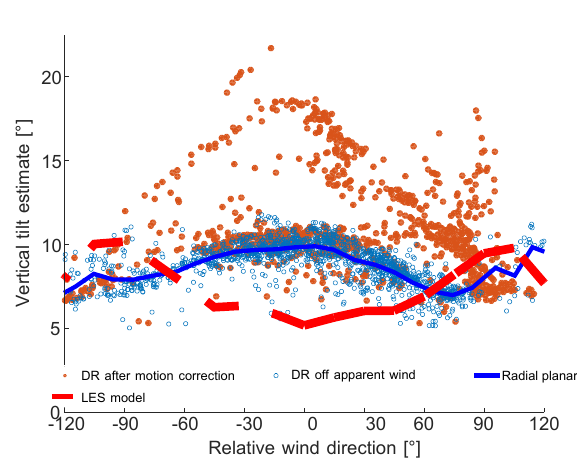
Figure A1. Estimates of the vertical tilt of the wind vector from the starboard side anemometer as a function of the relative wind direc- tion: (i) using the true wind speed in the double rotation (DR) tilt correction, as done in Landwehr et al. (2014) (orange dots); (ii) us- ing the apparent wind speed as suggested by Landwehr et al. (2015) (blue circles); (iii) using the radial planar fit (Landwehr et al., 2015) (blue line); (iv) from the LES model of the R/V Tangaroa (Popinet et al., 2004) (red dashed line).